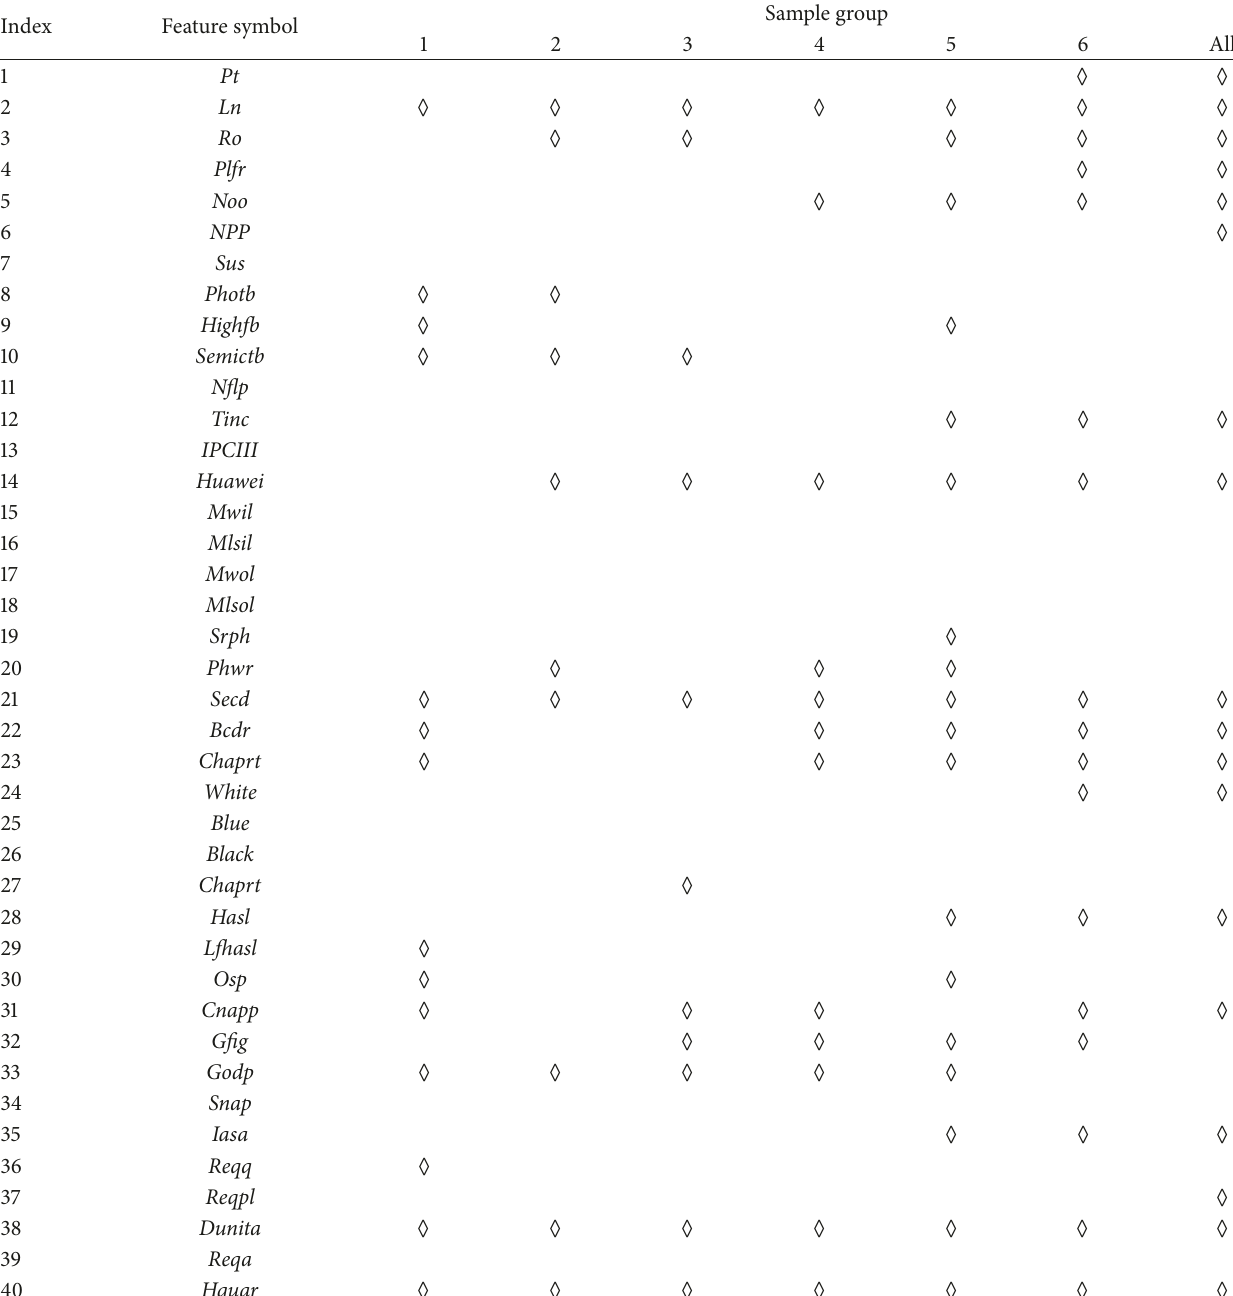
Table 4: Selected features for different group of the samples.